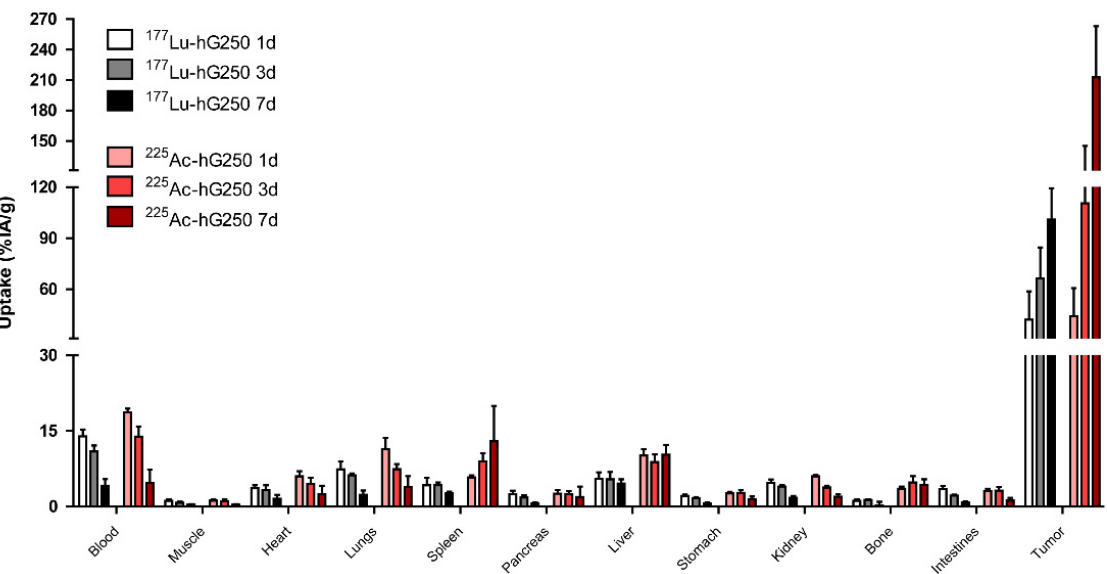
Figure 1. Biodistribution of radiolabeled hG250 in SK-RC-52 tumor-bearing mice at 1, 3, and 7 days after injection ( n = 5).